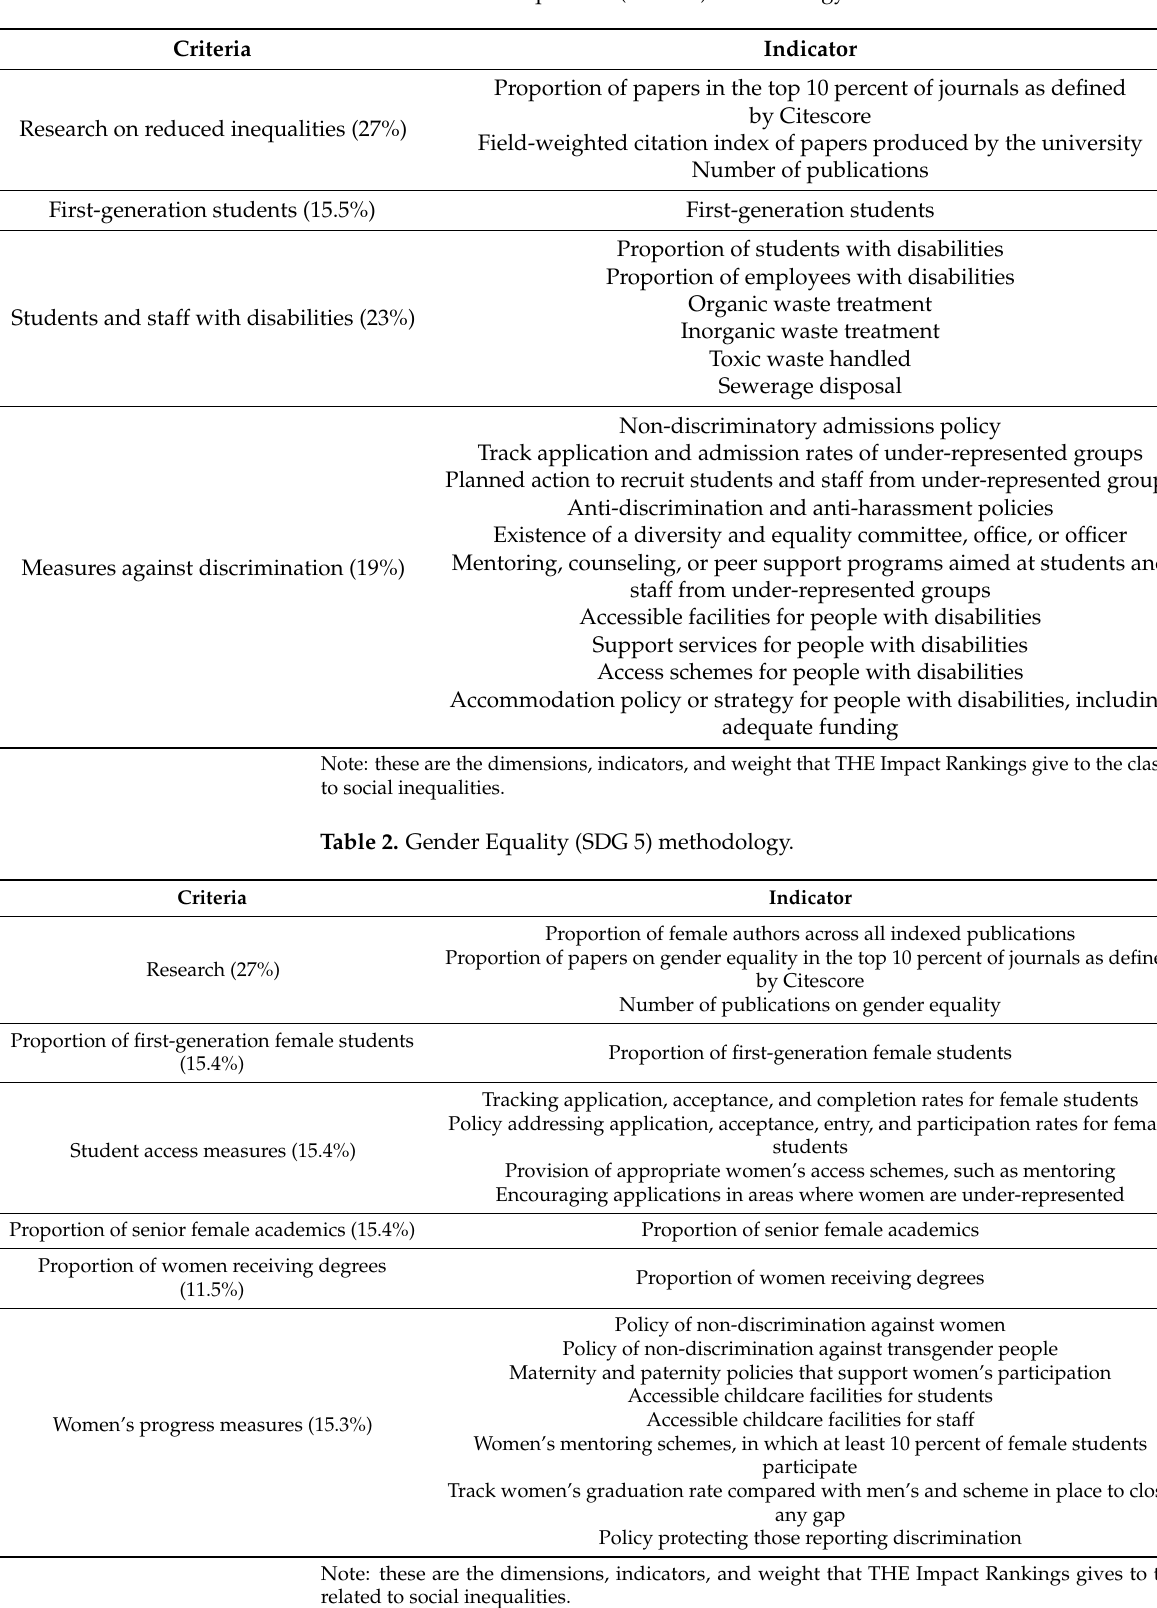
Table 1. Reduced inequalities (SDG 10) methodology.